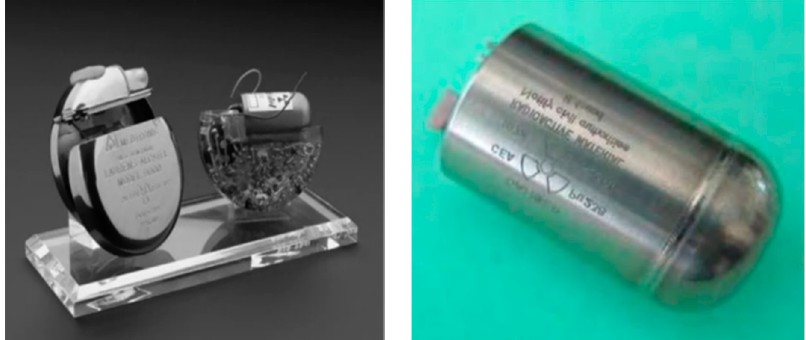
Figure 7. Left pacemaker and right RTG battery [108].